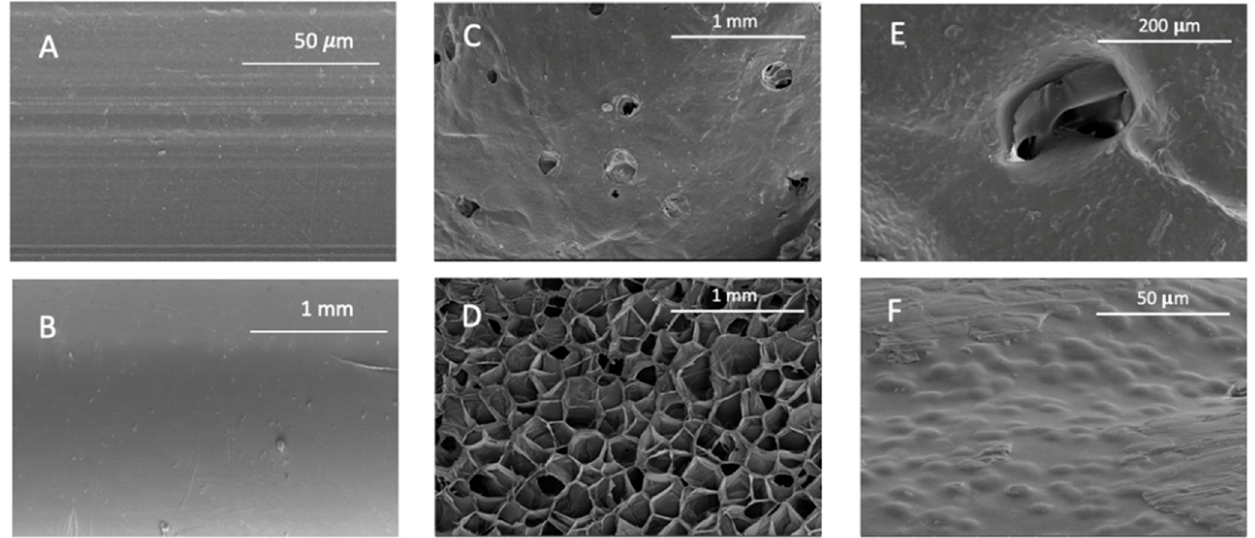
Figure 7. Appearance of raw PETG, ( A ) longitudinal and ( B ) cross section; PETG after scCO 2 contact, ( C ) longitudinal and ( D ) cross section; and PETG after impregnation with MLE, ( E ) longitudinal and ( F ) cross section.